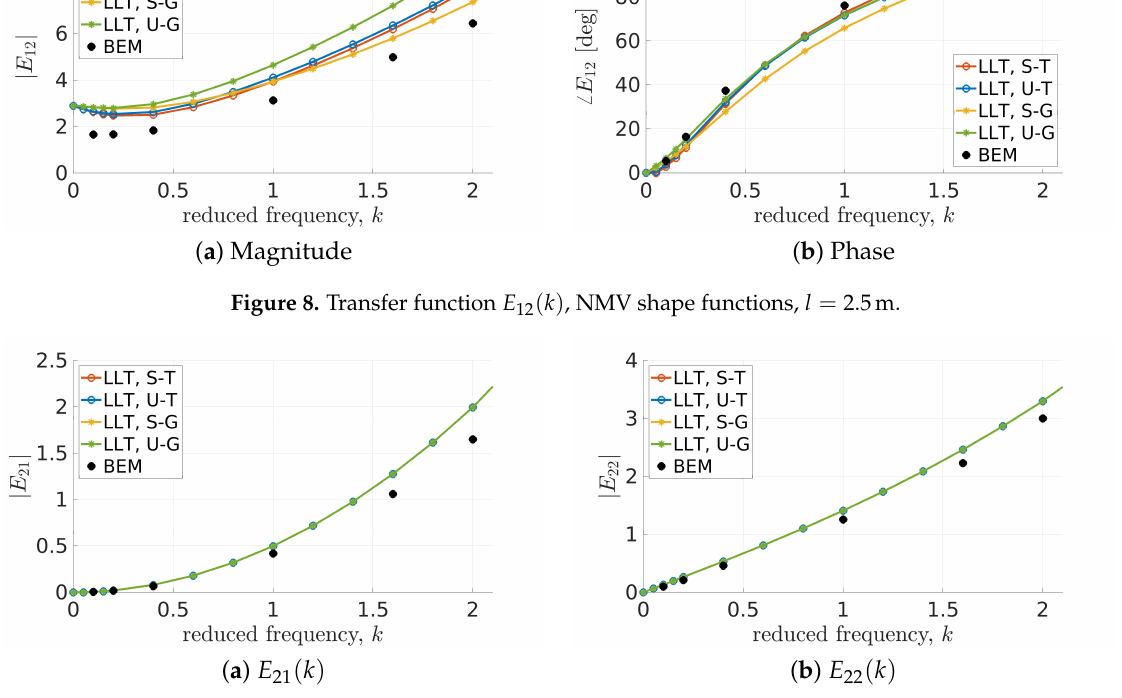
Figure 9. Magnitude of transfer functions E 21 ( k ) and E 22 ( k ) , NMV shape functions, l =